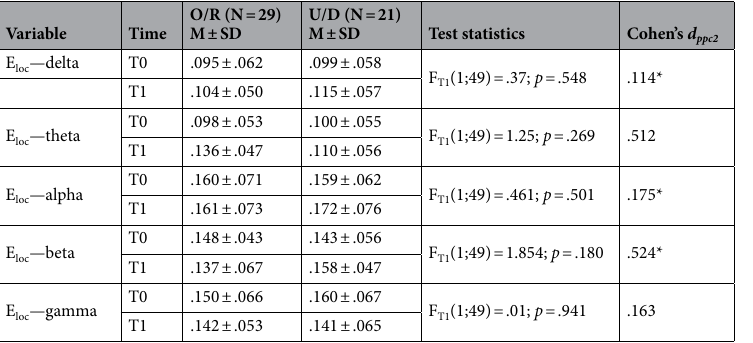
Table 3. ANCOVAs results for local efficiency (E loc ). Mean and standard deviation values for T1 are not adjusted for covariates (i.e., gender, age, and baseline EEG brain network metrics). M mean, SD standard deviation, E loc local efficiency, O/R organized/resolved group, U/D unresolved/disorganized group, T0 pre Adult Attachment Interview, T1 post Adult Attachment Interview. *Absolute value.